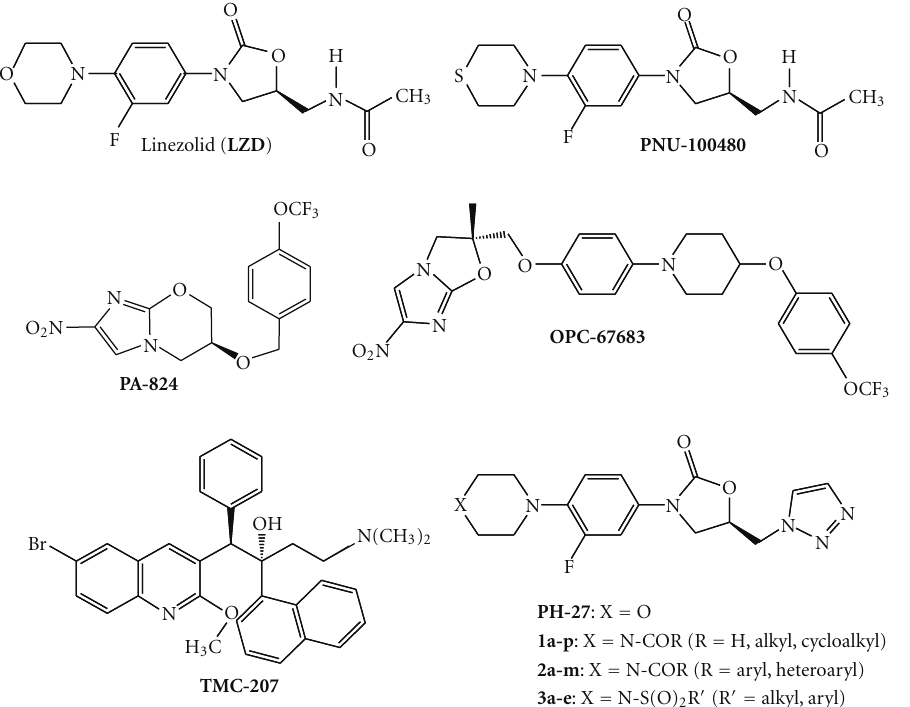
Figure 1: Chemical structure of oxazolidinone antibacterial agents and novel antimycobacterial